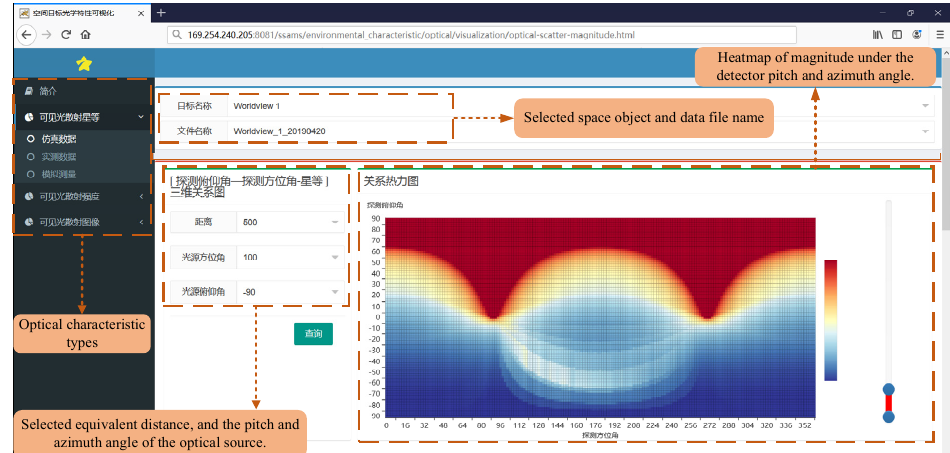
Figure 14. Home page of the visualization. The visualization displayed is the planar heatmap of the magnitude of the Worldview 1 satellite. The data of the space object needed to be visualized are obtained by selecting the space object and the data file name. By selecting the optical source pitch and azimuth, the planar heatmap under different optical sources can be obtained. In the heatmap, the x -axis is the detector azimuth, the y -axis is the detector pitch, and the value is the magnitude value. In this figure, the selected space object and the data file name are “Worldview 1” and “Worldview_1_20190420” respectively; the values of optical source pitch, optical source azimuth, and equivalent distance are − 90°, 100°, and 500 km, respectively.